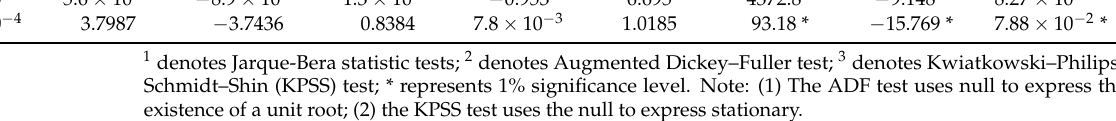
Figure 4. The graph of SSECI volatility increments from 2014 to 2020.